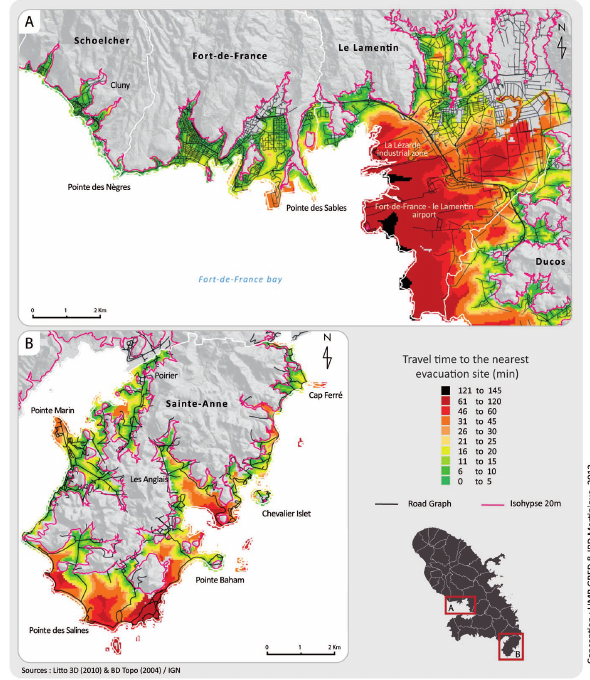
Fig. 2. Access time (min) to the closest evacuation site (20ma.s.l.): the case of Fort-de-France conurbation (A) and the touristic munic- ipality of Sainte-Anne (B)